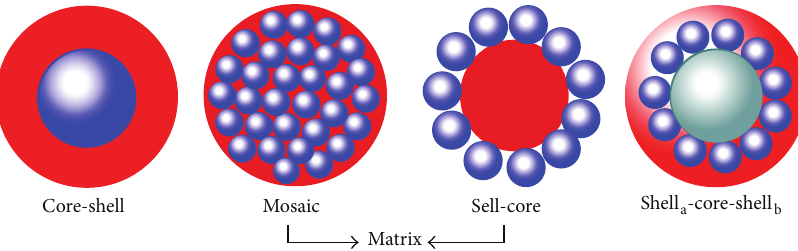
Figure 14: The schematics of organic coating models such as core-shell, mosaic, and shell-core structures [184].